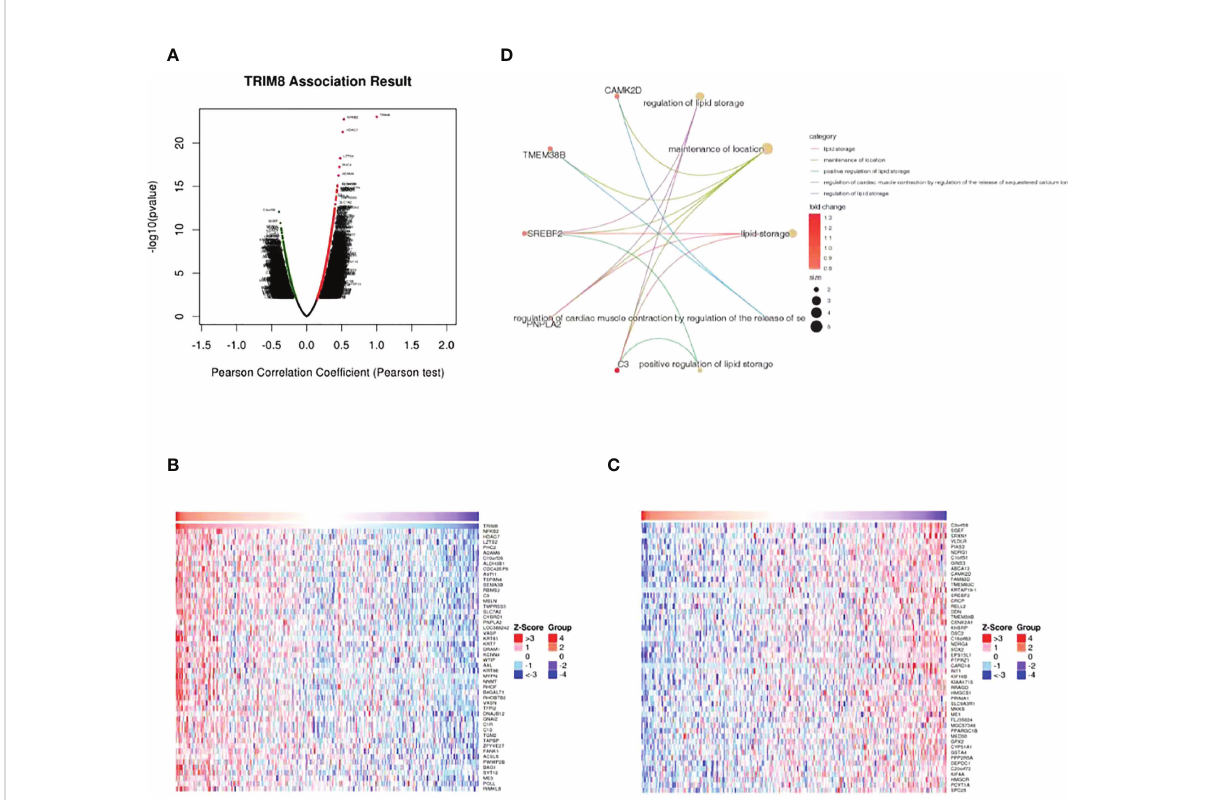
FIGURE 5 Genes associated with TRIM8 expression in cervical cancer. (A) Correlations between TRIM8 and differently expressed genes from LinkedOmics database. (B, C) Heat maps show the genes that are positively or negatively correlated with TRIM8 (Top 50 genes). (D) GO enrichment of top 20 positive and negative candidate